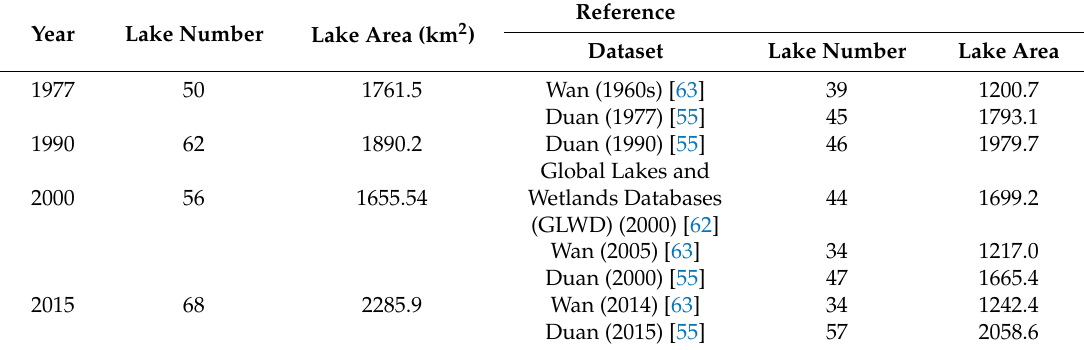
Table 6. Area comparison of lakes in the QB between the results in this study and reference